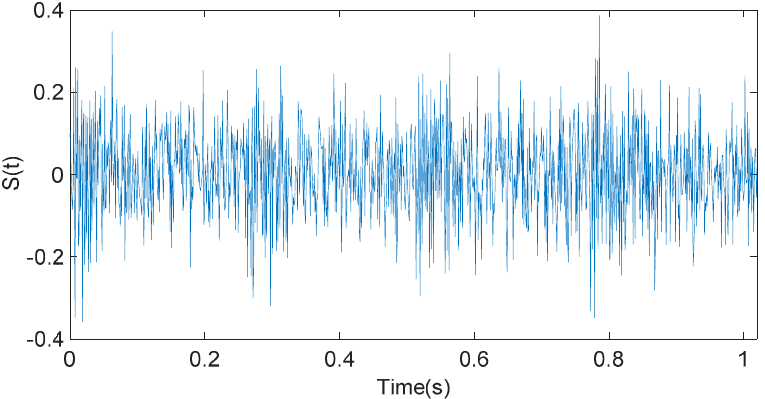
Figure 2. The frequency of the simulation component signal k ( t ) obtained by Fast Fourier Transform (FFT).